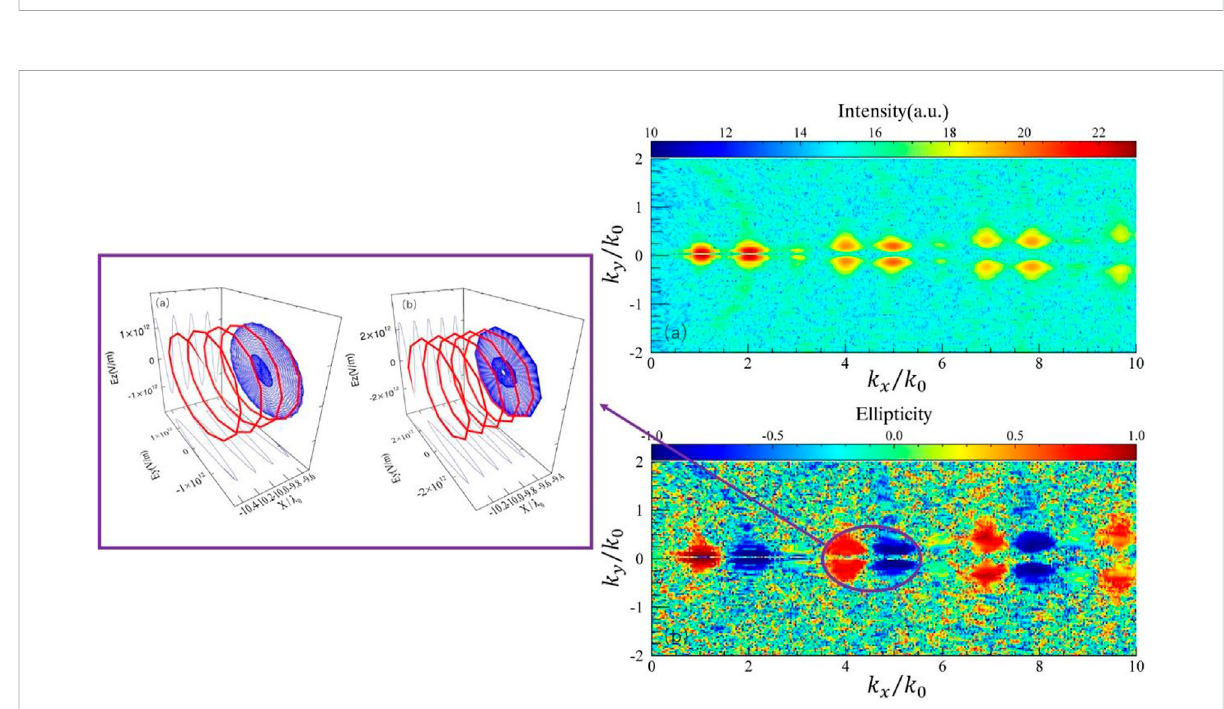
FIGURE 2 (A) The intensity of generated harmonics versus k x / k 0 and k y / k 0 in frequency domain, (B) The corresponding ellipticity distribution versus k x / k 0 and k y / k 0 in frequency domain (the spatial frequencies along X and Y directions k x , k y are normalized by the fundamental laser wave number k 0 (cid:2) 2 π / λ 0 ). The inset displays the three-dimensional waveforms of the electric fi elds of a group of neighboring harmonics ( n (cid:2) 4 ,